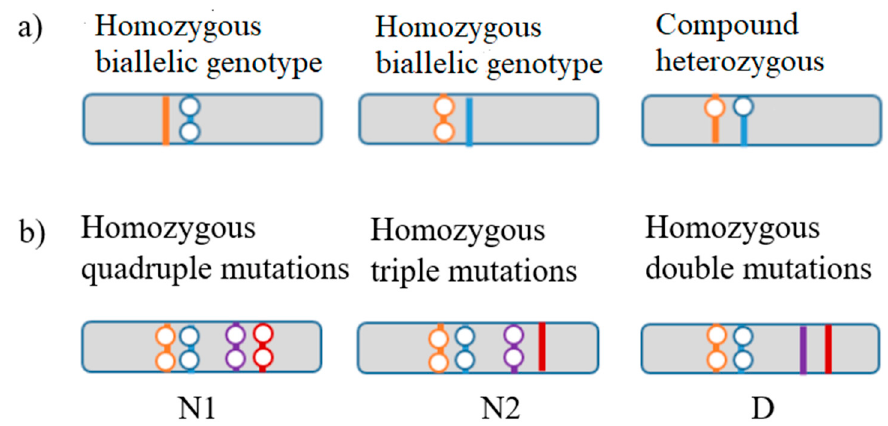
Figure 2. Mutational specter in the PAH gene ( a ) in contemporary human populations; ( b ) in the analyzed archaic human subjects, the Altai Neanderthal (N1), the Vindija cave Neanderthal (N2), Denisovan individual, and Mezmaiskaya Cave Neanderthal (D).